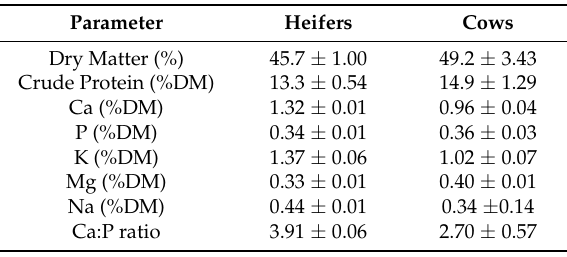
Table 1. Typical feed constitution for each animal type (heifers and cows). Each analyte was measured in duplicate from feed laid out for each animal type. Values are mean ±